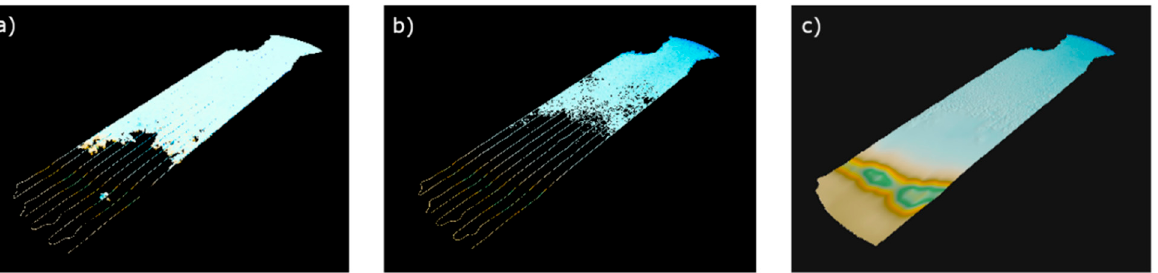
Figure 18. Visualization of subsequent stages of USV and UAV data processing: ( a ) USV survey and UAV PCG point cloud, ( b ) combined USV and UAV data: CSPCG HL, and ( c ) digital model of the bathymetric surface created by the kriging method.